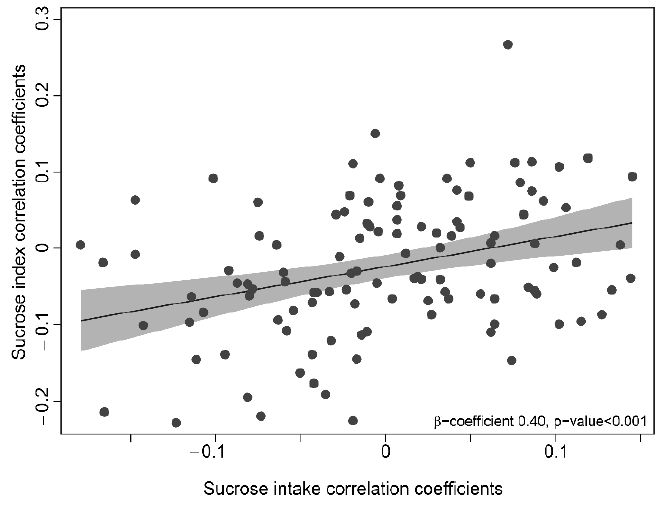
Figure 4. Box plots illustrating the distributions of ( A ) estimated daily sucrose (g/day) and ( B ) the sucrose index by age group, ( C , D ) estimated sucrose intake in tertile groups (low, medium, high) based on the distribution of the sucrose index in the ( C ) younger and ( D ) older group, and ( E ) scatter plot between sucrose index values and sucrose E% values with regression line (95% CI).